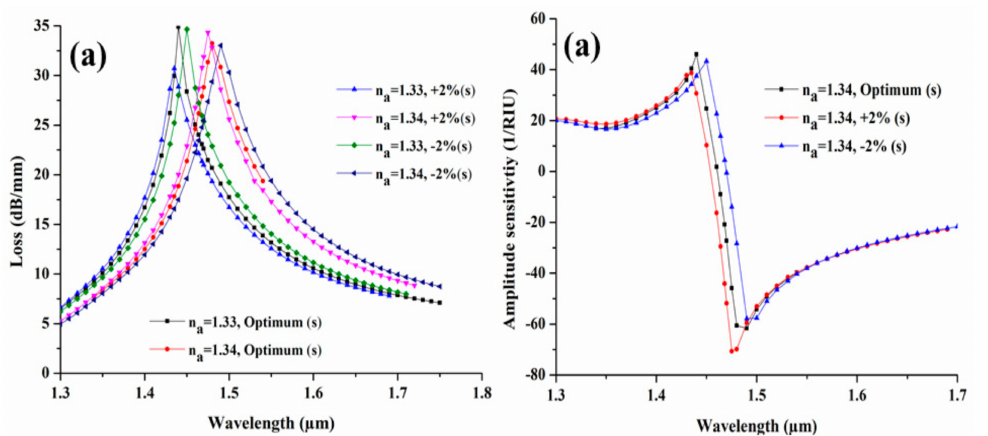
Figure 11. ( a ) Loss spectra and ( b ) amplitude sensitivity, with ± 2% tolerance in CSC size